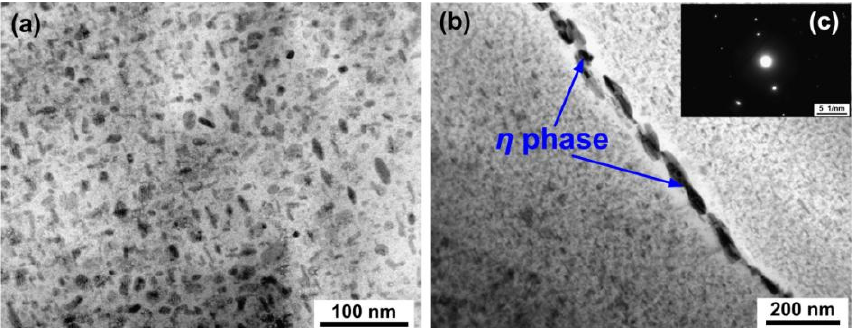
Figure 4. TEM images of the 7085-T7452 aluminum alloy specimen: ( a ) grain interior morphology; ( b ) grain boundary morphology; and ( c ) electron diffraction pattern of grain boundary precipitates (GBPs).